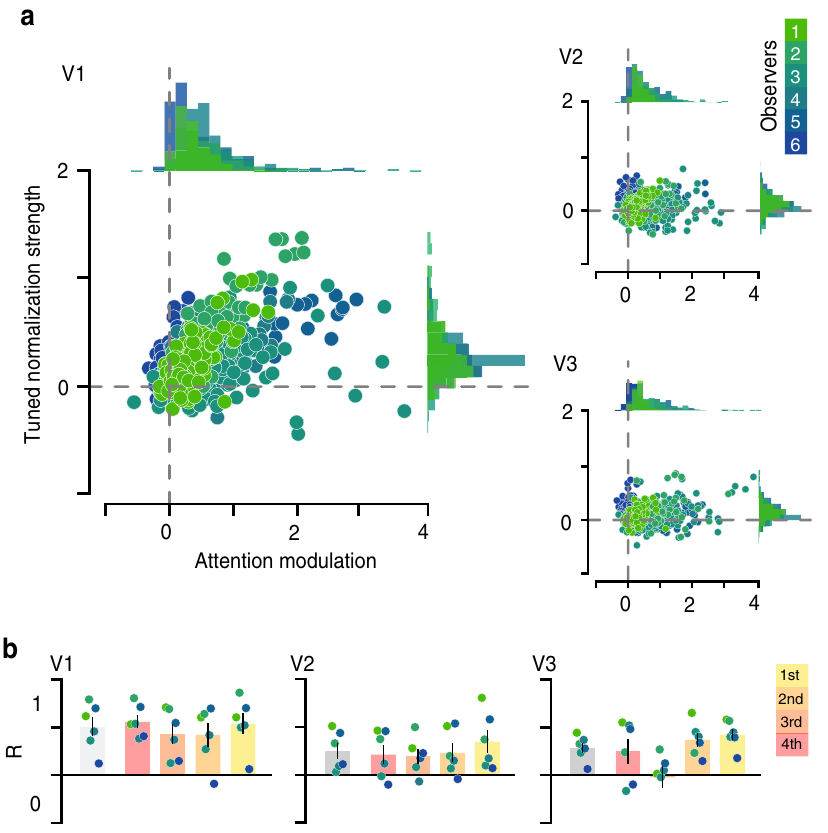
Fig. 4 Attentional modulation as a function of tuned normalization strength. a A tight relationship between tuned normalization strength and attentional modulation is evident for the top 25% selected voxels for each observer, see Methods. Dots illustrate individual voxels within an area, colors represent a unique participant. b Spearman correlations were computed for each observer, gray bars represent the mean correlation across observers, while the colored bars represent the correlations when the voxel selection is broken down into four bins based on the independent visual localizer (red: bottom 25%, yellow: top 25%). All Spearman correlations were transformed into a Fisher-Z-statistic to allow for statistical comparisons between observers, see Methods. Error bars denote ± 1 S.E.M.; N = 6; colored dots illustrate individual